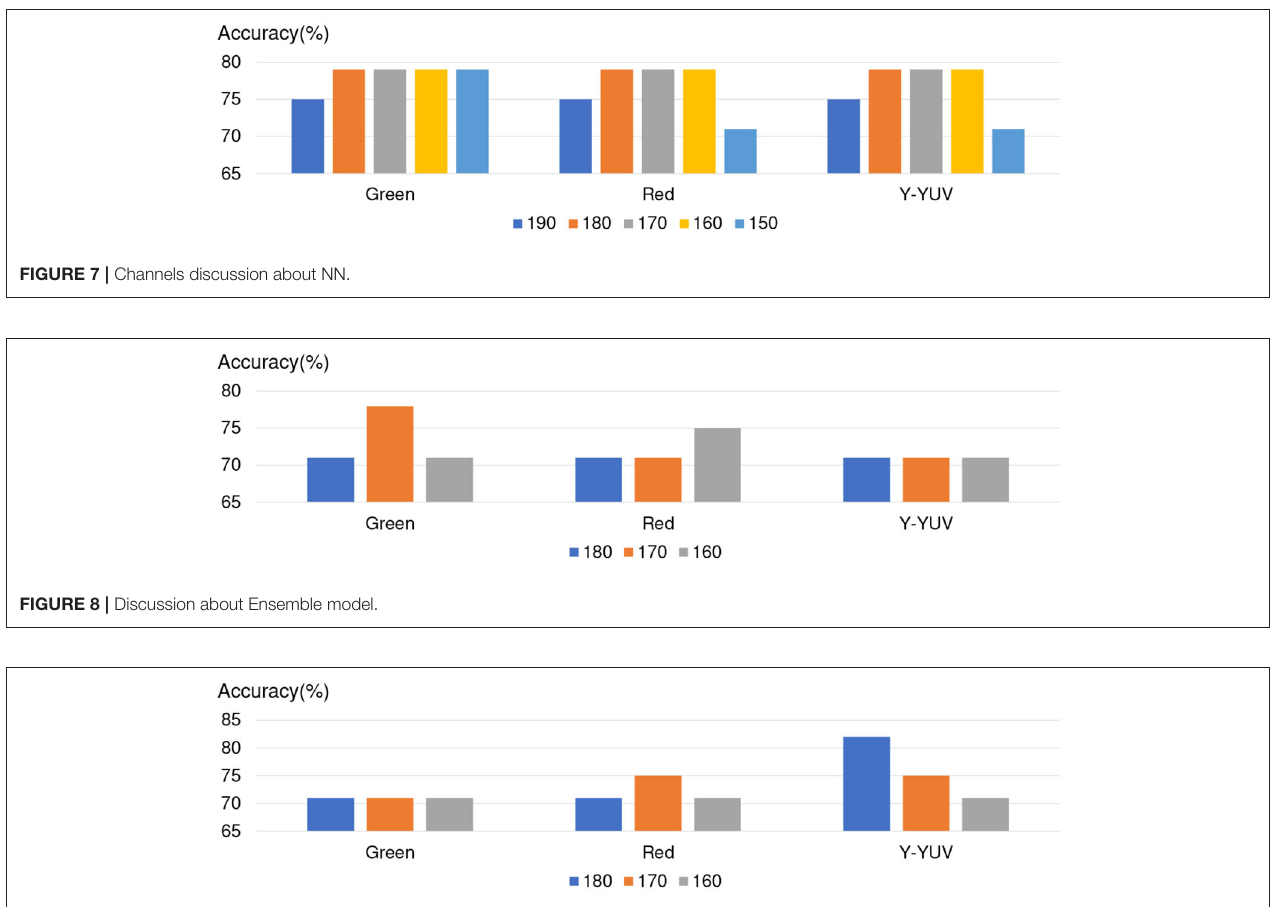
FIGURE 9 | Discussion on experimental results of NN (validation =